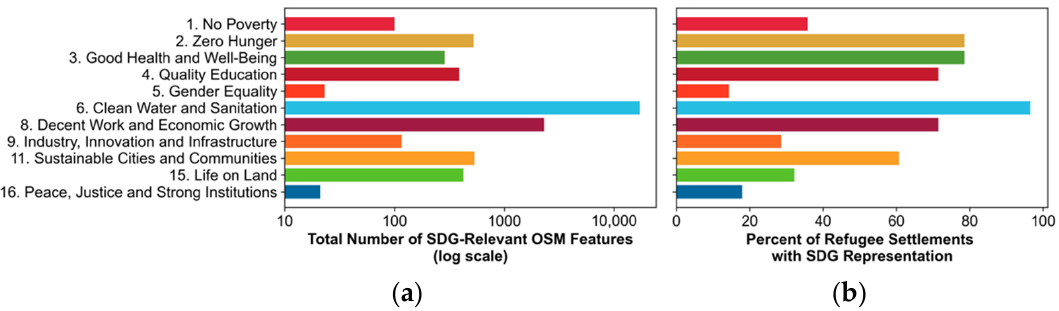
ISPRS Int. J. Geo-Inf. 2021 , 10 , x FOR PEER REVIEW Figure 6. Distribution of SDG-relevant OSM data by ( a ) total number of OSM features (logarithmic scale) and ( b ) percentage of refugee settlements with representation by at least one SDG-relevant OSM feature.